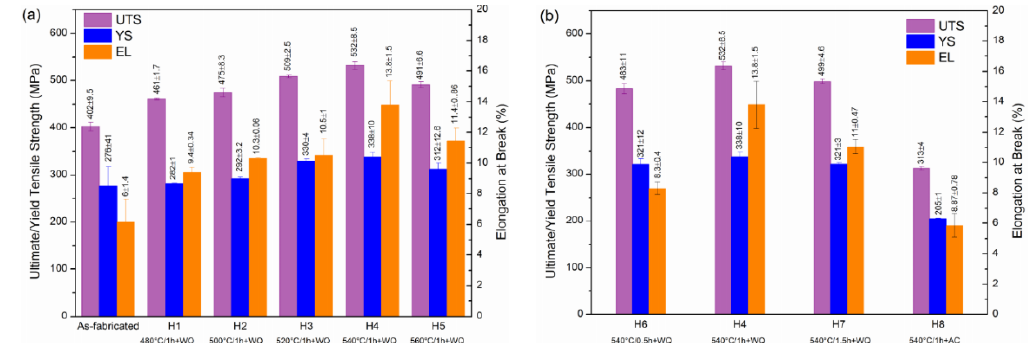
Figure 52. Mechanical properties of the SLM Al-Cu-Mg alloy in as-fabricated condition and after different heat treatments. WQ and AC refer to water quenching and air-cooling, respectively. The mean values and standard deviations are listed above the columns in the figure [117]. ( a ) as-fabricated and H1-H5 heat treated conditions and ( b ) H4, H6, H7 and H8 heat treated conditions. Copyright 2016. Adapted permission from SPIE publishers (Figure 3 [117]).